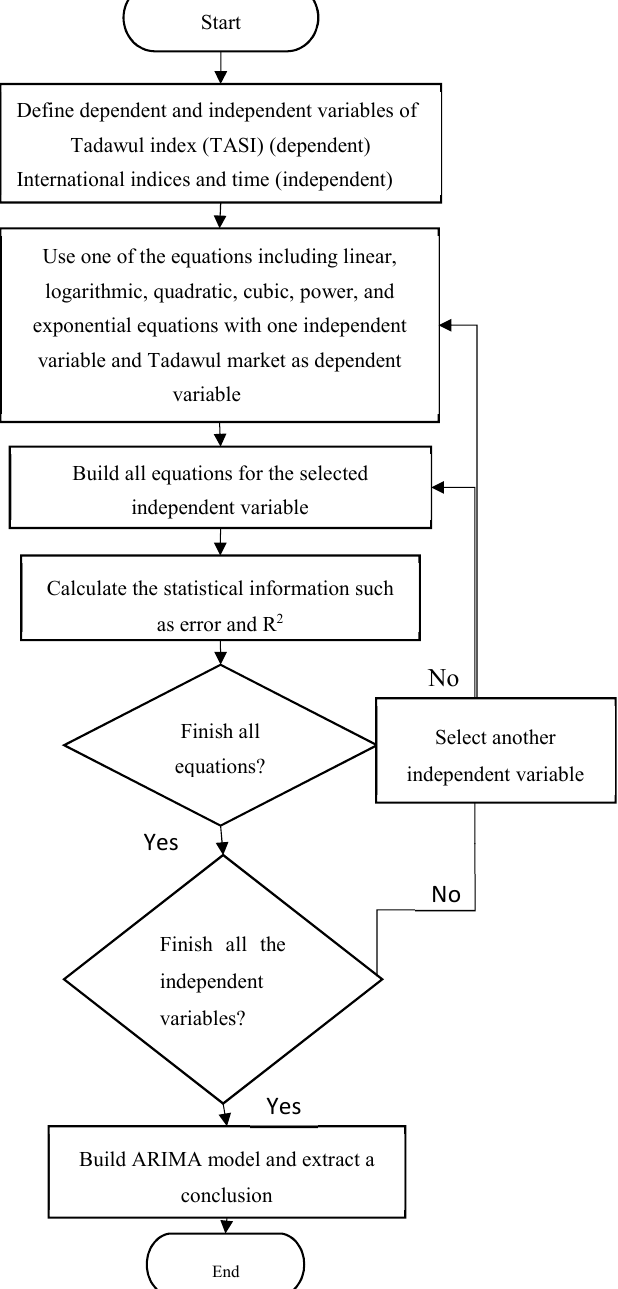
Figure 1. Flowchart of the proposed methodology.